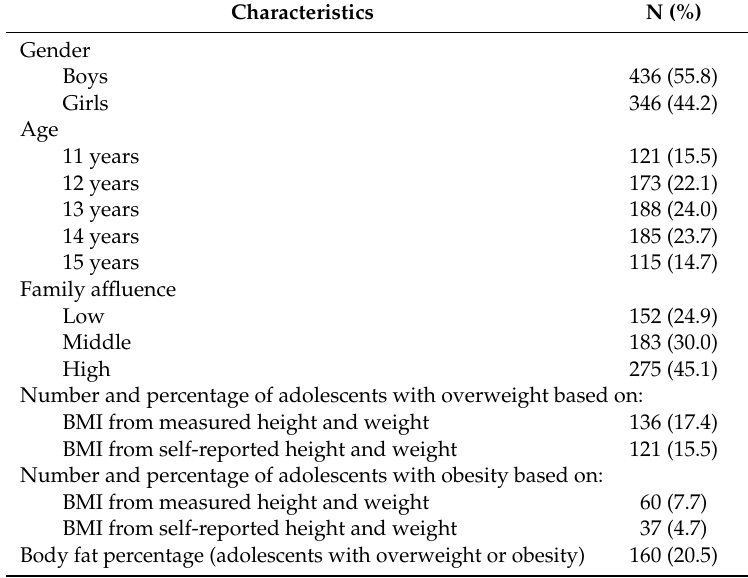
Table 1. Characteristics of the sample (N = 782, 11–15-year-old Slovak school-aged children, data collected in